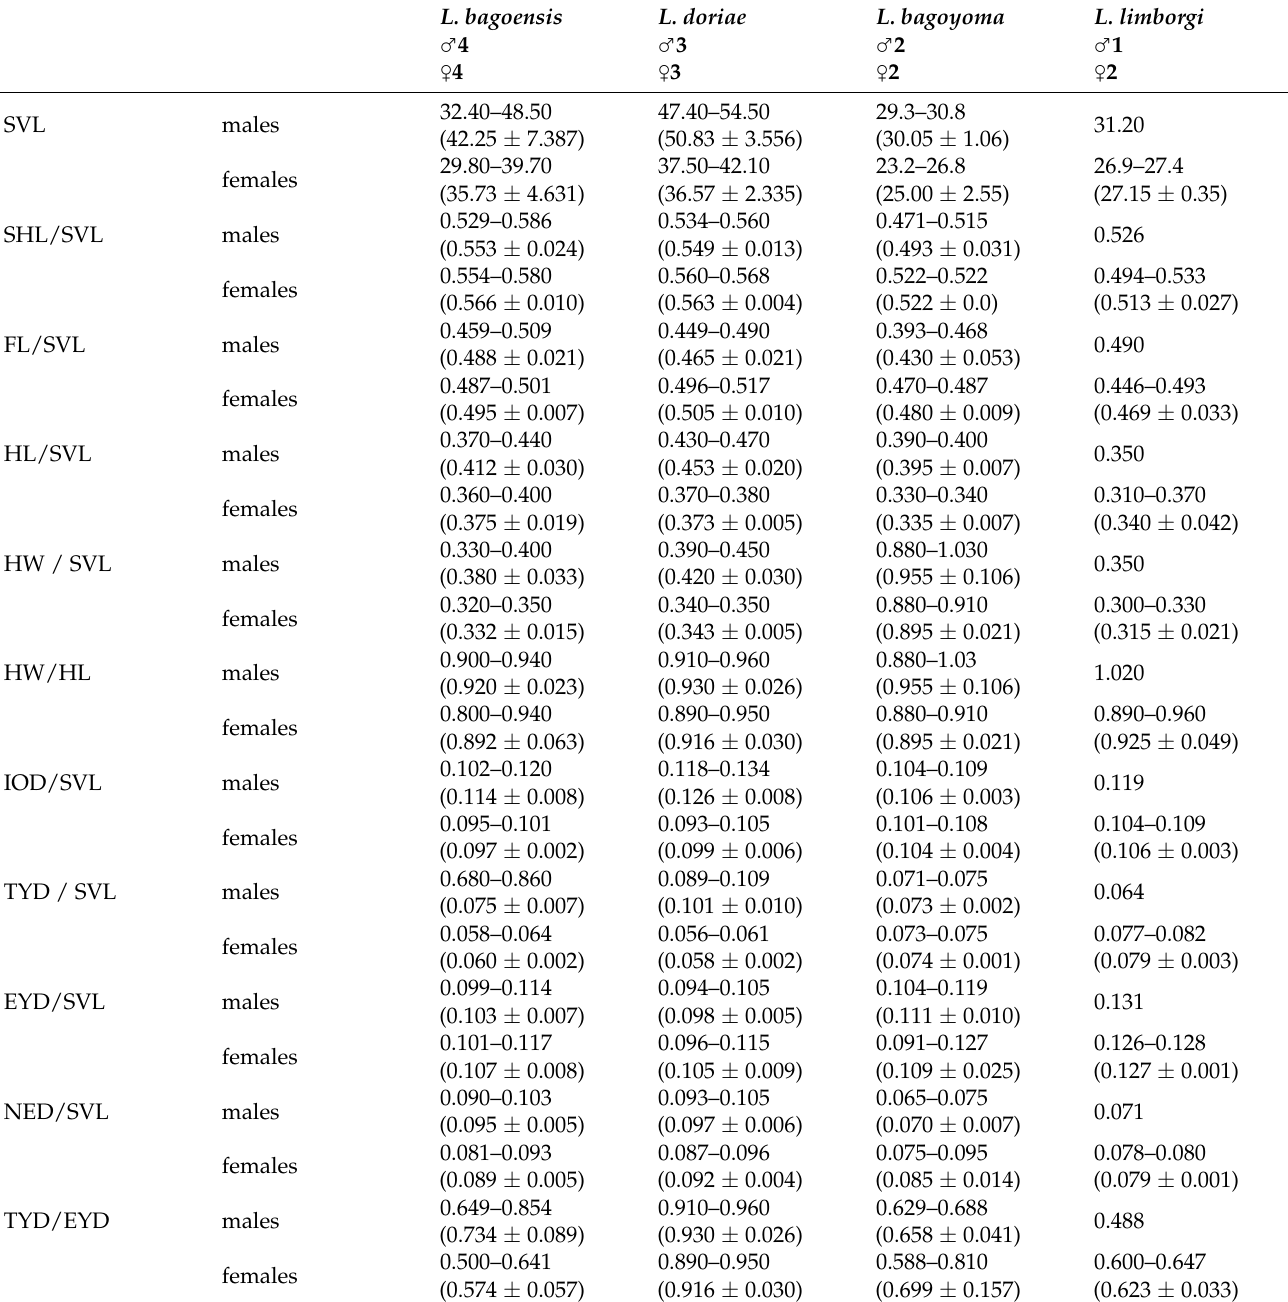
Table 3. Selected measurements and proportions of the two new species of Limnonectes described herein and the species they are most closely related to. Range is followed by mean value and standard deviation in parentheses. For abbreviations see